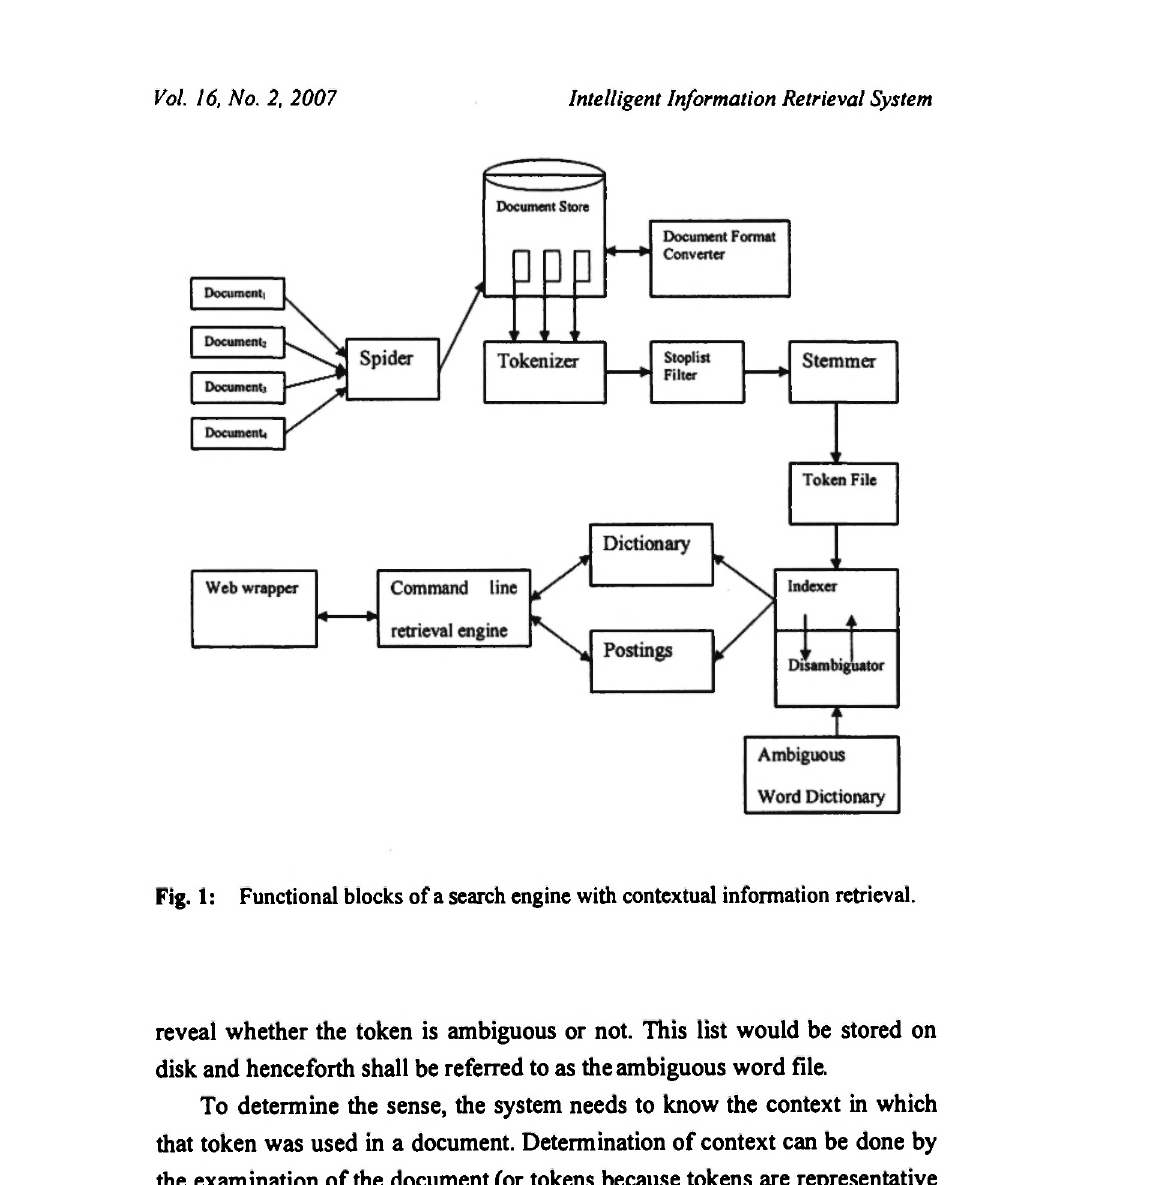
Fig. 1: Functional blocks of a search engine with contextual information